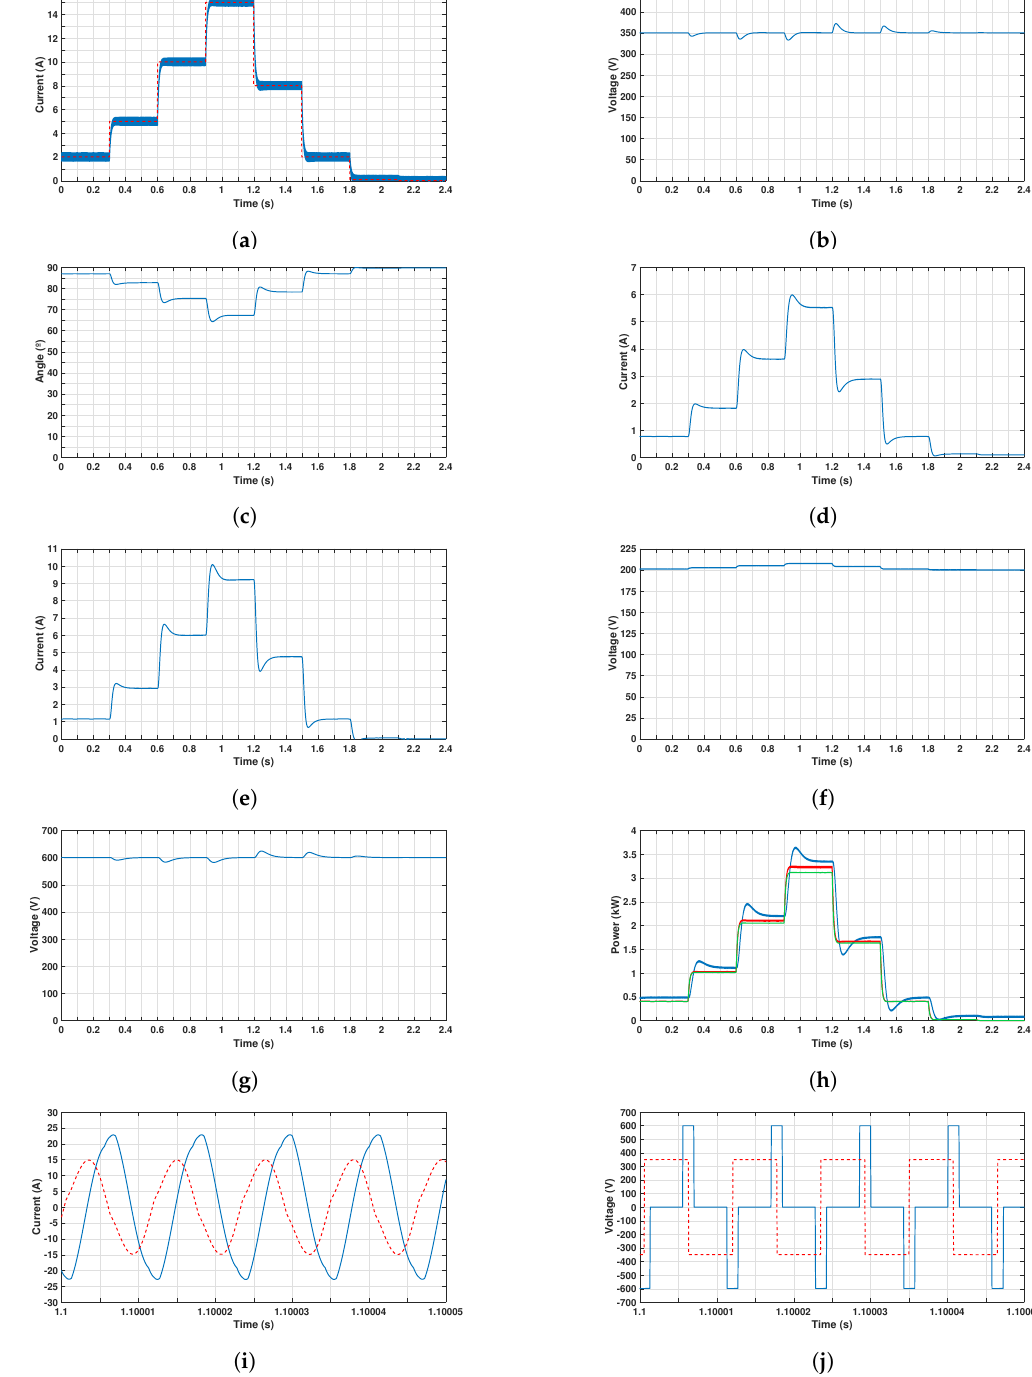
Figure 12. Results obtained for the G2V mode. Time responses of: ( a ) the battery current i b (blue) and the reference i ∗ (red); ( b ) the DC voltage v DC 2 ; ( c ) the phase-shift angle α ; ( d ) the current i in ; ( e ) the current i 0 ; b ( f ) the voltage of the battery v b ; ( g ) the DC voltage v DC 1 ; ( h ) the grid power P g (blue), the power at the input of the DC–DC converter P dc (red) and the battery power P b (green); ( i ) currents of the compensated magnetic coupler i 1 (blue), and i 2 (red); ( j ) voltages across the compensated magnetic coupler v 1 (blue), and v 2